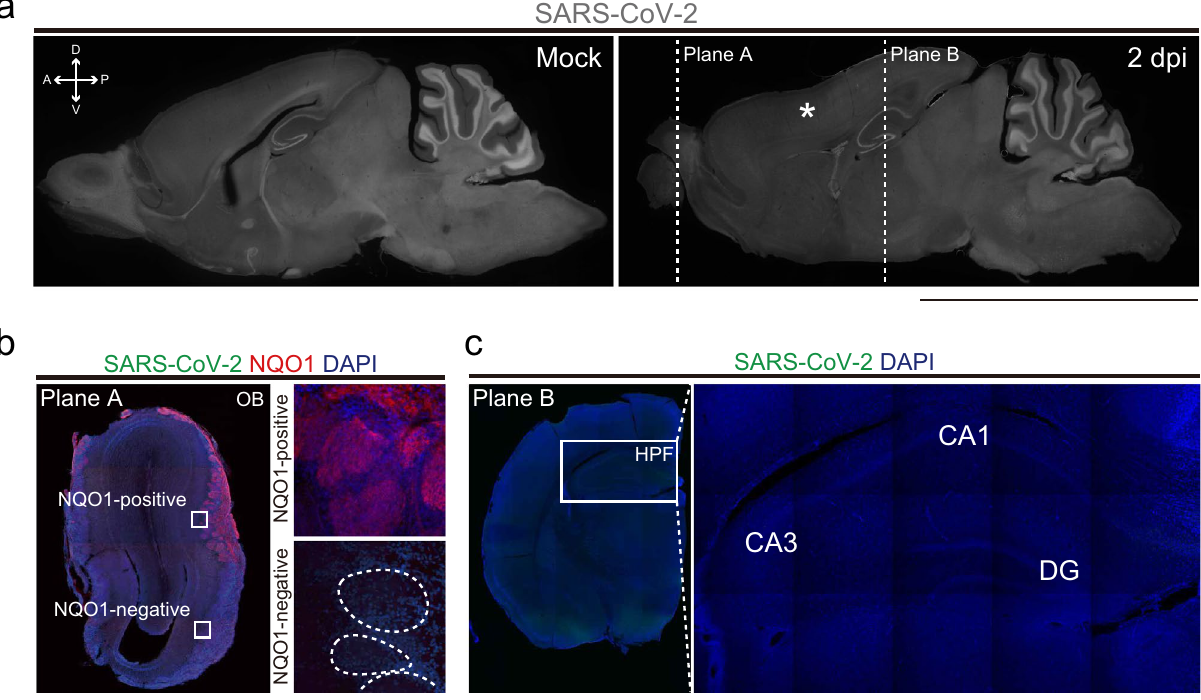
Figure 2. Distribution of SARS-CoV-2 in the OB. (a) Sagittal sections of the whole brain stained by SARS- CoV-2 in mock and 2 dpi. Planes A and B are shown as coronal sections in Fig. 2b,c. The asterisk indicates the frontal cortex. Scale bar, 1 cm. (b) Representative image of the coronal section of the OB. Right panels are high-magnification images of the GL in NAD(P)H quinone oxido-reductase 1 (NQO1)-positive (upper) and –negative (lower) regions. White dashed circles indicate glomeruli. Scale bars, 1 mm (left), 100 μm (right). (c) Left panel shows a representative image of the coronal section of the cerebral hemisphere. The white box indicates hippocampal formation (HPF). Right panel is a high-magnification image of the HPF; CA1, CA3, and DG. Scale bar, 1